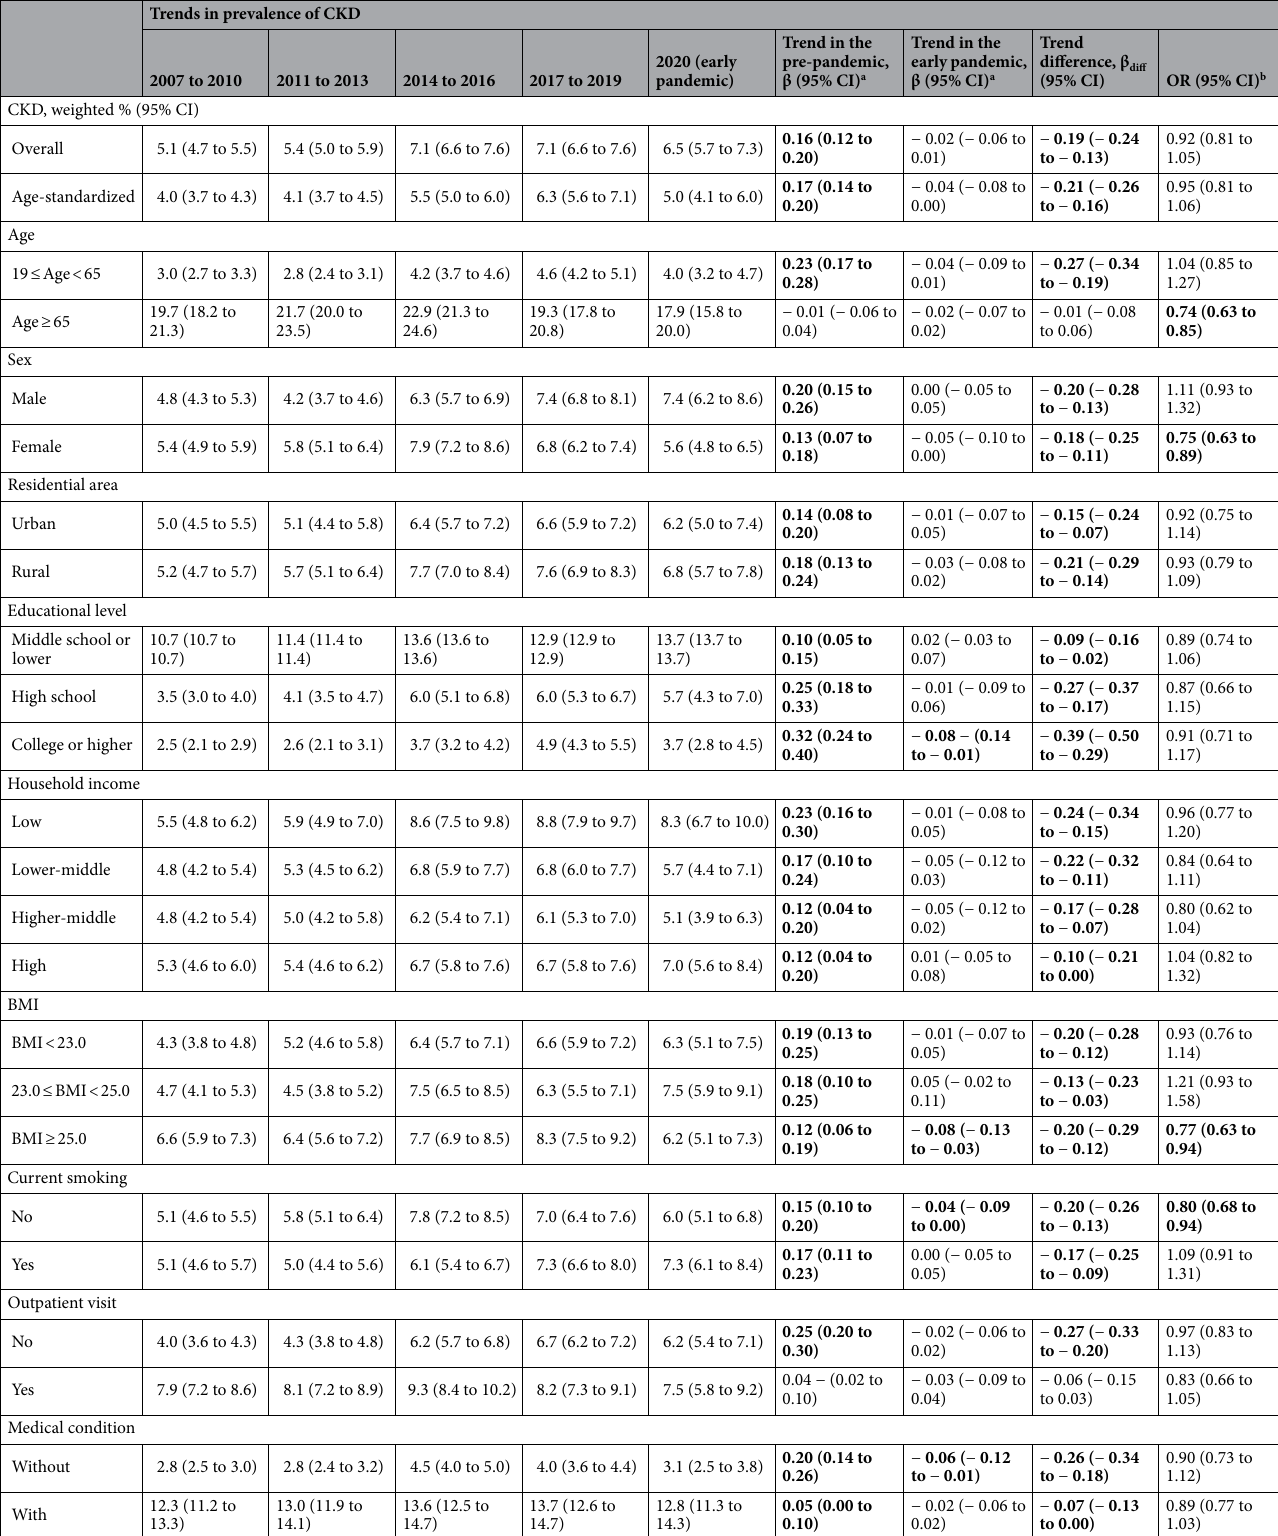
Table 2. Chronic kidney disease weighted prevalence and trend in adults from 2007–2020. BMI body mass index, CKD chronic kidney disease, CI confidence interval, KNHANES Korea National Health and Nutrition Examination Survey, OR odds ratio. a Estimated β was calculated to analyze the year cycle (2007–2010,